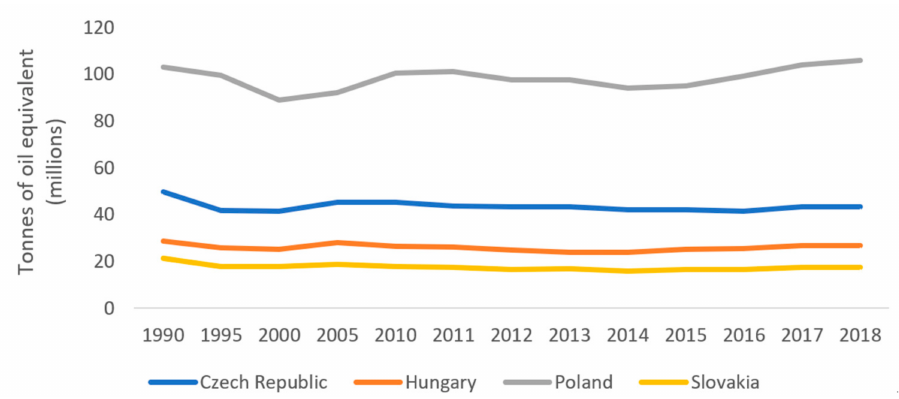
Figure 3. Total primary energy supply in the Visegrad Group countries in 1990–2018.